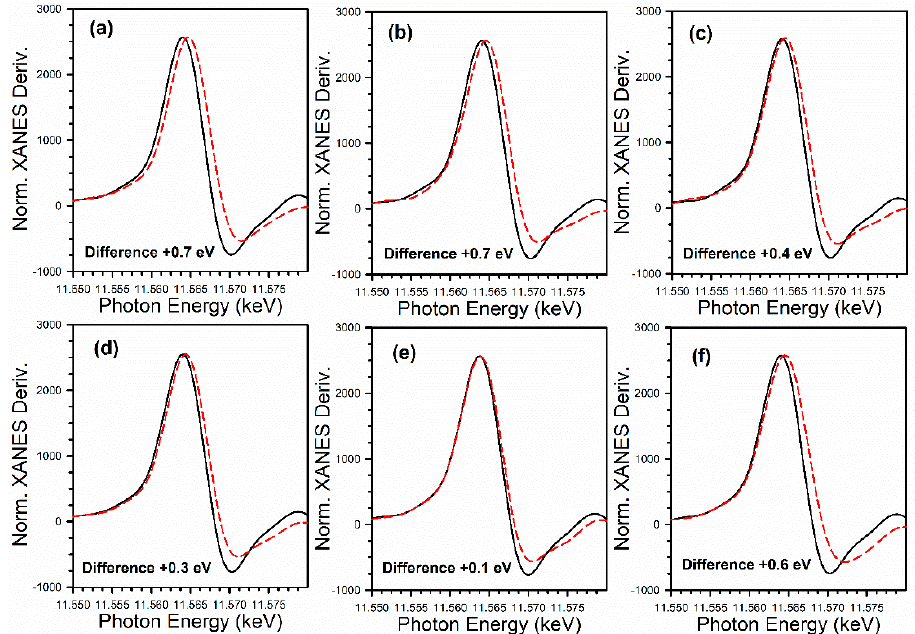
Figure 15. XANES derivative spectra at the Pt L 3 edge that are normalized to the height of the Pt metal foil of (solid black line) Pt metal foil reference and catalysts, including ( a ) 2%Pt/ZrO 2 , ( b ) 2.9% Cs-2% Pt/ZrO 2 , ( c ) 4.8% Cs-2% Pt/ZrO 2 , ( d ) 5.8% Cs-2%Pt/ZrO 2 , ( e ) 10.4% Cs-2% Pt/ZrO 2 , ( f ) 14.5% Cs-2% Pt/ZrO 2 .